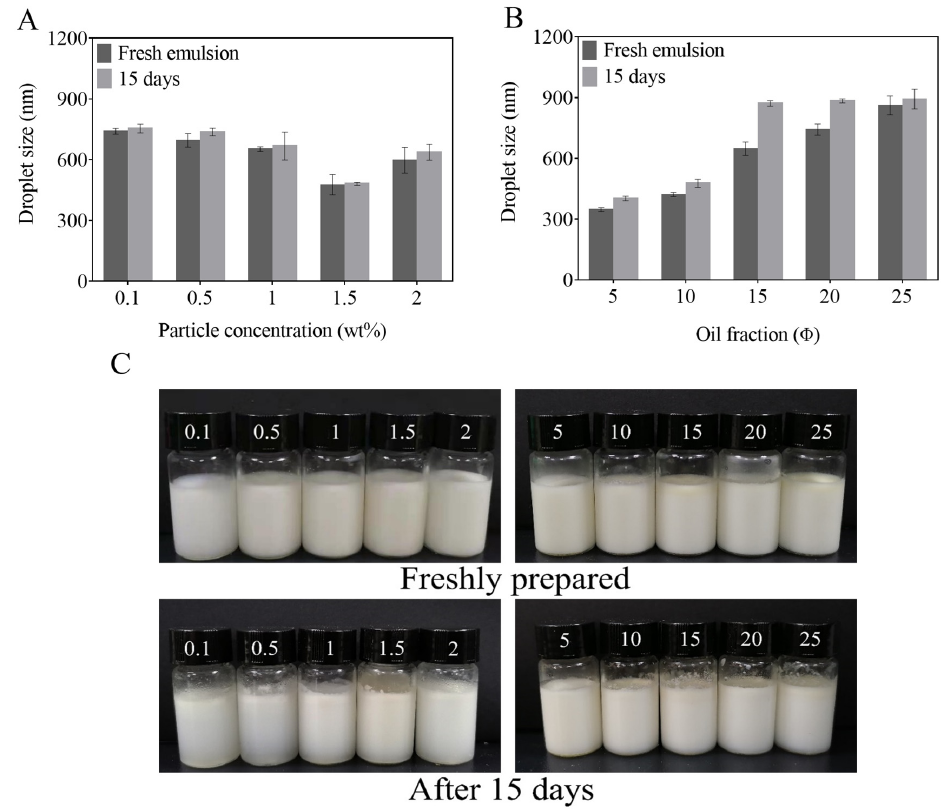
Figure 3. Effects of particle concentration ( A ) and oil phase fraction ( B ) on the droplet size and appearance ( C ) of Pickering emulsions stabilized by Z-R/P 2:1 particles for 0 and 15 days of storage.